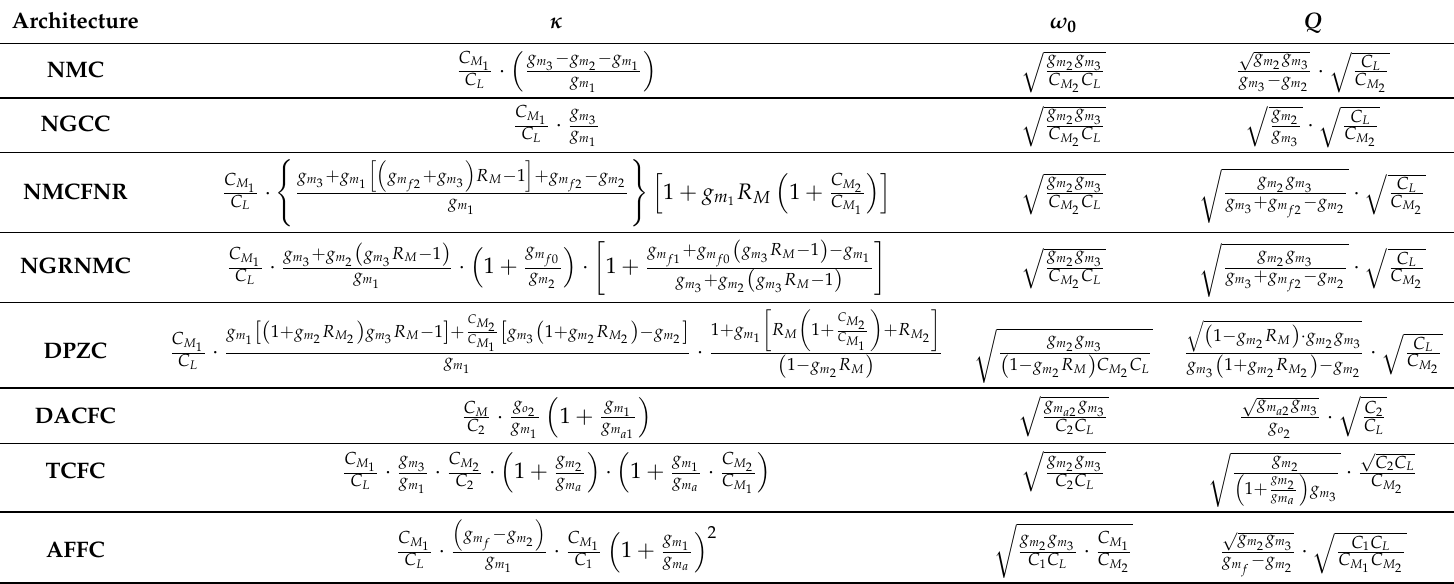
Table 6. Analytical expressions for the proposed FoM and non-dominant pole parameters for the compensation architectures of Figure 10.